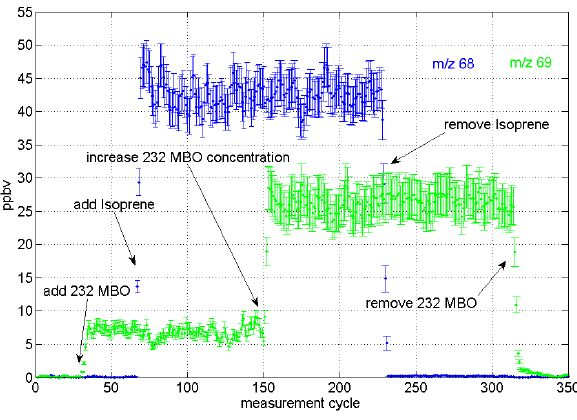
Figure 5: Interference test: each measurement cycle represents a 1.5 s time interval; 232 MBO (green) and Isoprene (blue) concentrations are varied as indicated in the graph. Error bars represent 1 σ .